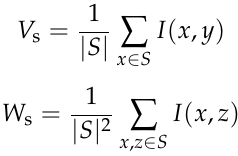
xi—i-th measurement data point, n—total number of data in the measurement Application of the Minimum Redundancy Maximum Relevance (MRMR) Algorithm in